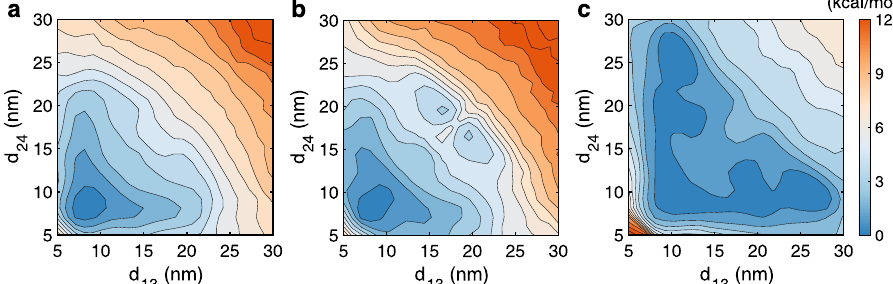
Fig. 6 Impact of histone H4 tail acetylation on the free energy landscape of chromatin folding. a , b , c Contour of two dimensional free energy pro fi le as a function of the distance between 1 – 3 ( d 13 ) and 2 – 4 ( d 24 ) nucleosomes at 1 kcal/mol interval for the system that removes the positive charge on K16 ( a ), that removes the positive charge on K16 and biases the tail to a beta-sheet conformation ( b ), and that removes all the nine positive charges on the tail ( c